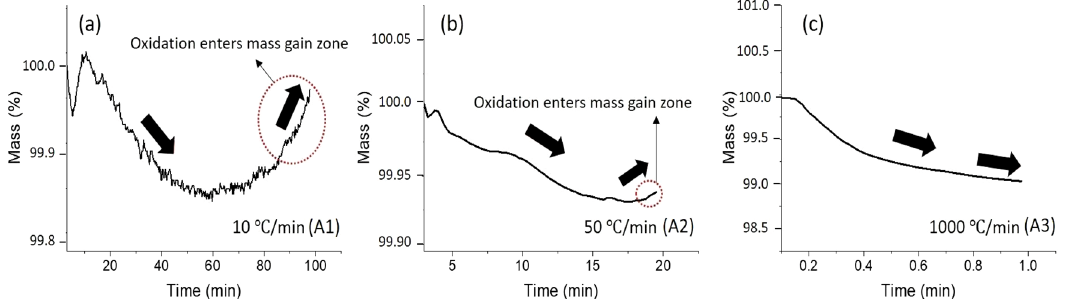
Fig. 3 TGA analysis for change in mass with time of non-isothermally treated L-DED fabricated IN718. TGA plots correspond to heating rates of a 10 °C/min, b 50 °C/min, and c 1000 °C/min.